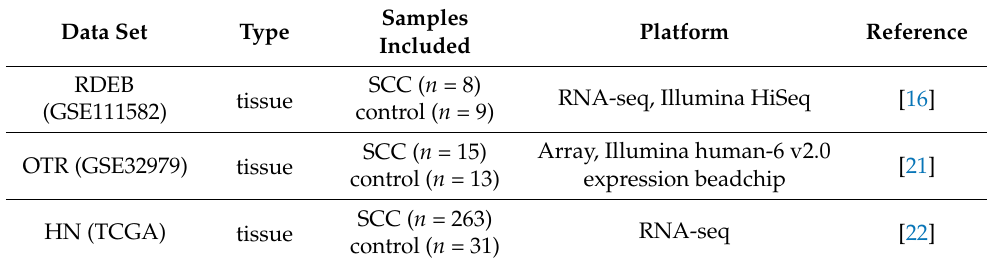
Figure 1. Analysis and evaluation of transcriptome similarities between organ transplant recipient (OTR)-, recessive dystrophic epidermolysis bullosa (RDEB)-, head and neck (HN)- squamous cell carcinoma (SCC). ( A ) Scheme of data processing workflow. ( B ) Uniform Manifold Approximation and Projection (UMAP) plot illustrates the distinct separation of tumor and control samples (dashed line) from all three data sets. All genes expressed in the three data sets were considered for dimension reduction. Gene expression data was z-transformed across samples within respective data sets. ( C ) Overlap of differentially expressed genes (DEGs) (min. 2-fold, adjusted- p < 0.01) between tissue data sets. ( D ) Heat map of 183 shared DEGs between all three data sets. Gene expression data were z-transformed. Columns: samples, Rows: DEGs. Samples and genes were organized by hierarchical clustering. ( E ) Plots show the Molecular Signature Database (MSigDB) hallmark gene sets significantly (adjusted p < 0.05) enriched in shared DEGs. Table 1. Data sets used for determination of DEG-based tumor